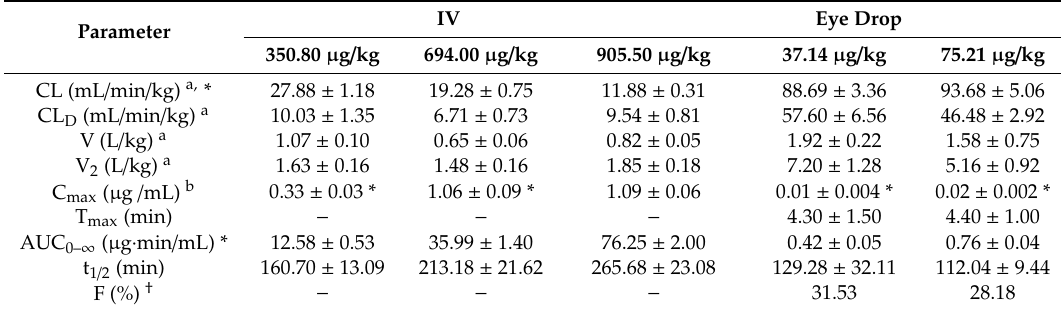
Figure 3. Plasma concentration-time profiles of CK41016 described by the two-compartment model after IV ( A ) or eye drop administration ( B ) in rats. Each value represents the mean ± SD ( n = 3–6). Table 2. Pharmacokinetics (PK) parameters of CK41016 following IV or eye drop administration in rats (mean ± SE, n =